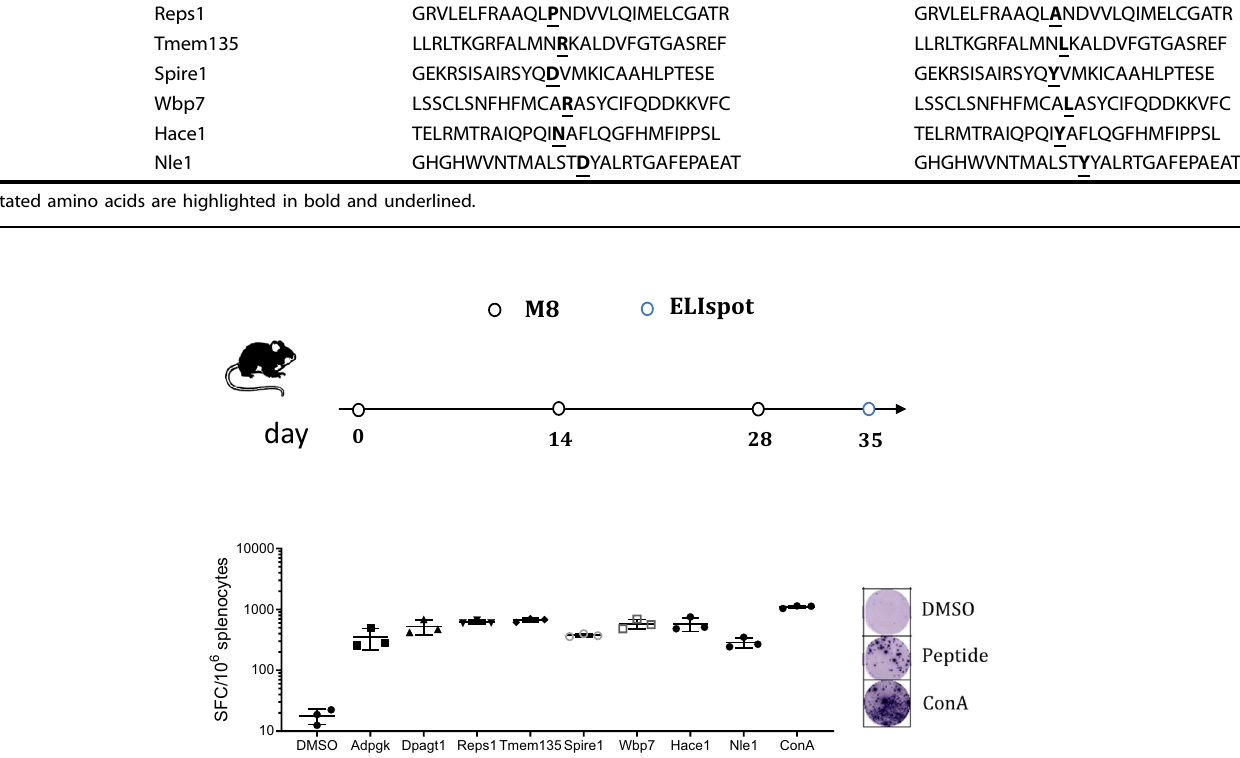
Fig. 1 Immune responses induced by M8 vaccine. C57Bl/6 mice were vaccinated at day 0, 14 and 28, while neoantigen-speci fi c immune responses were analyzed on day 35 on splenocytes by IFN γ ELISpot stimulated with individual peptides. ConA served as a positive control. Neoantigen-speci fi c measurements are reported corresponding to the neoantigens listed in Table 1. Each symbol represents an individual sample ( n = 3). A representative image of the experiment is on the right. Values are from one of two